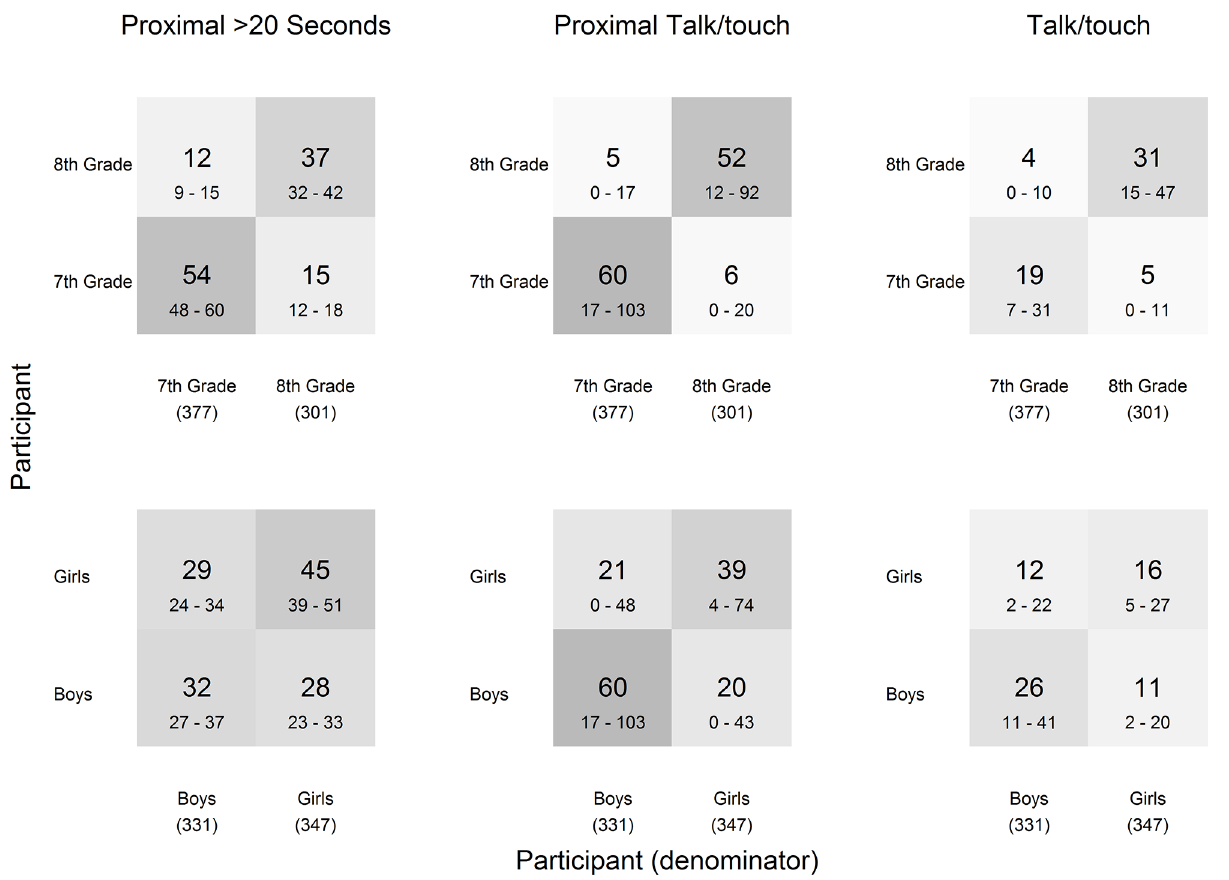
Fig 7. Contact matrices of estimated average contacts per student. Contacts matrices are presented for P ( > 20 seconds), PT, and T contacts per student during class-time and lunch and include 95% confidence intervals (below).